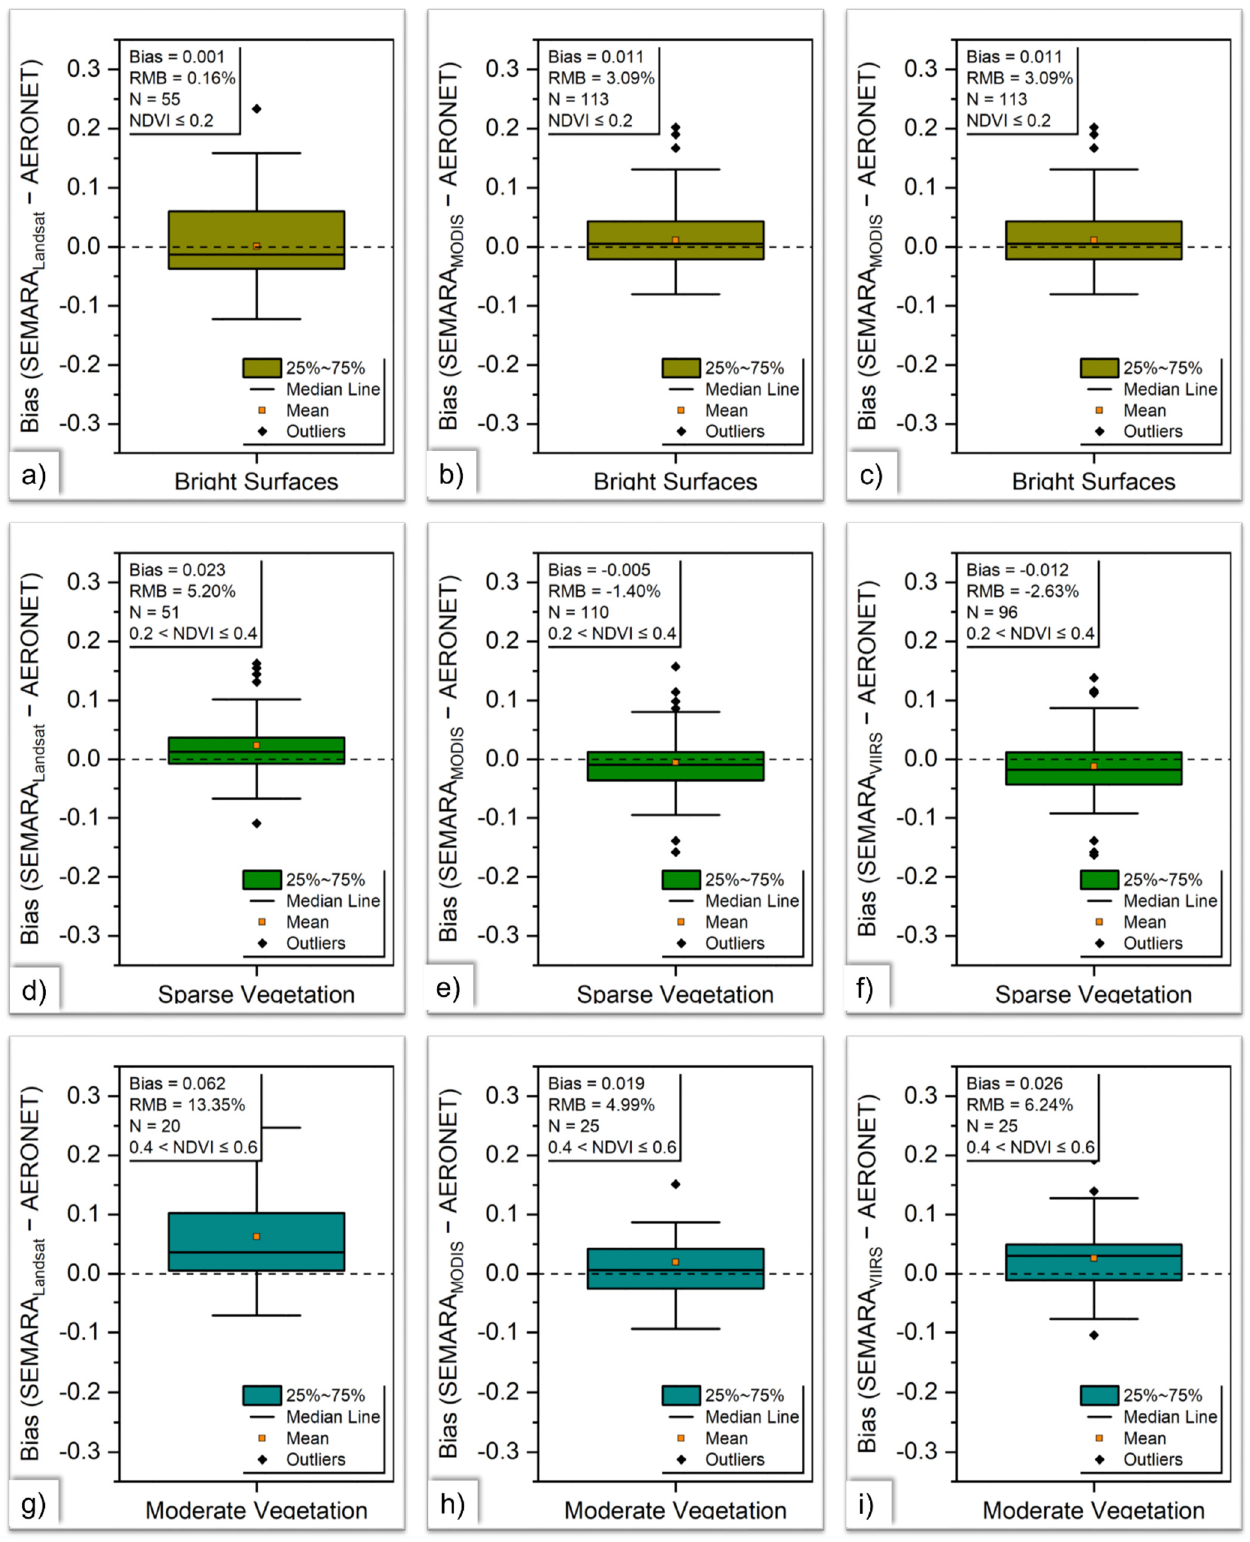
Figure 2. Box plots for bias (SEMARA AOD—AERONET AOD) over different land surfaces stratified based on NDVI values, i.e., ( a – c ) NDVI ≤ 0.2 (bright surfaces), ( d – f ) 0.2 < NDVI ≤ 0.4, and ( g – i ) 0.4 < NDVI ≤ 0.6.